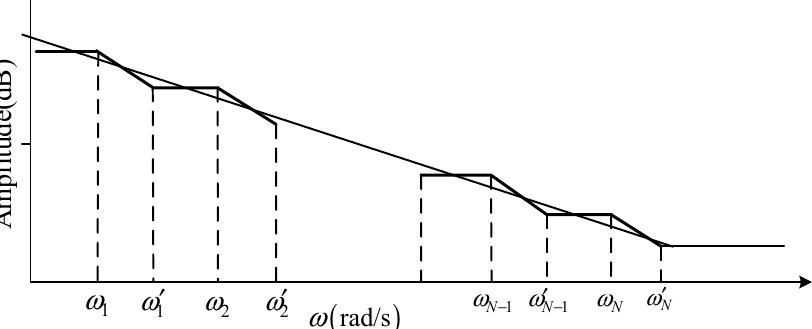
where δ is the fractional order, 5 N = . Compared with in- teger-order PID, FOPID has more integral order λ and differential order μ , which can control the controlled object more flexibly, so as to meet the performance index of complex system. Figure 12 is the FOPID control plane diagram. Figure 11. Piecewise polyline approximation of filters. Figure 11. Piecewise polyline approximation of filters.